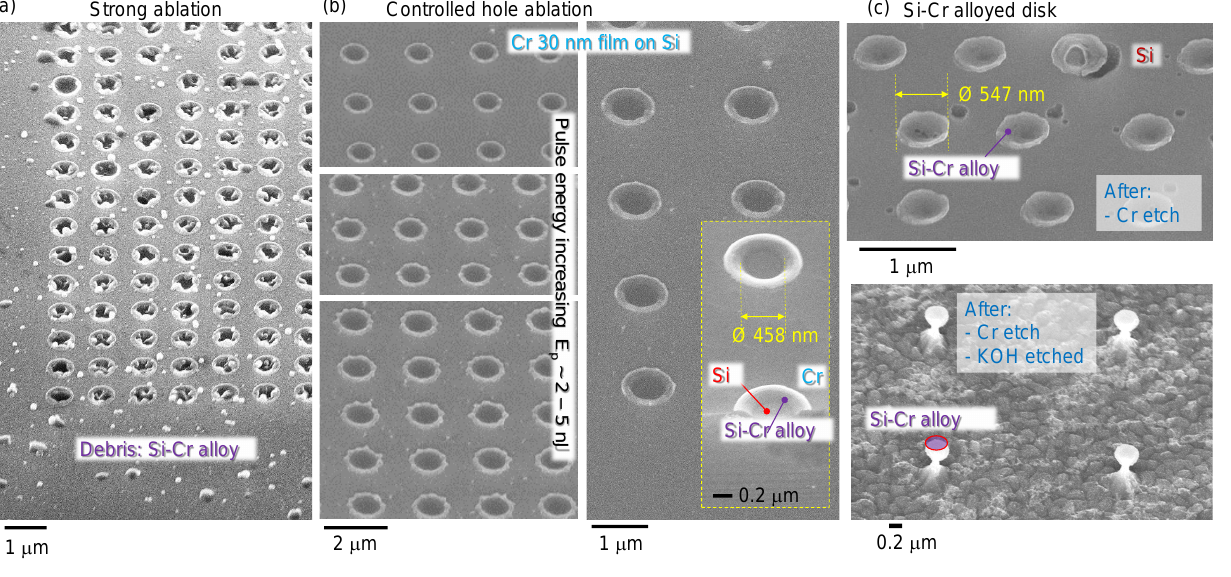
Figure 3. Pulse energy control: hole, ring, disk, nanoparticles. ( a ) SEM image of Cr 30 nm mask ablated by 515 nm/230 fs single pulses focused with NA = 0.9 objective lens; pulse energy E p > 12 nJ (on sample). ( b ) Controlled opening of mask window at 2–5 nJ pulse energies. Inset shows tilted view of cross section. ( c ) Focal center made from alloyed Si and Cr with sub-diffractional diameter < 700 nm disks. Pulse energy E p = 1